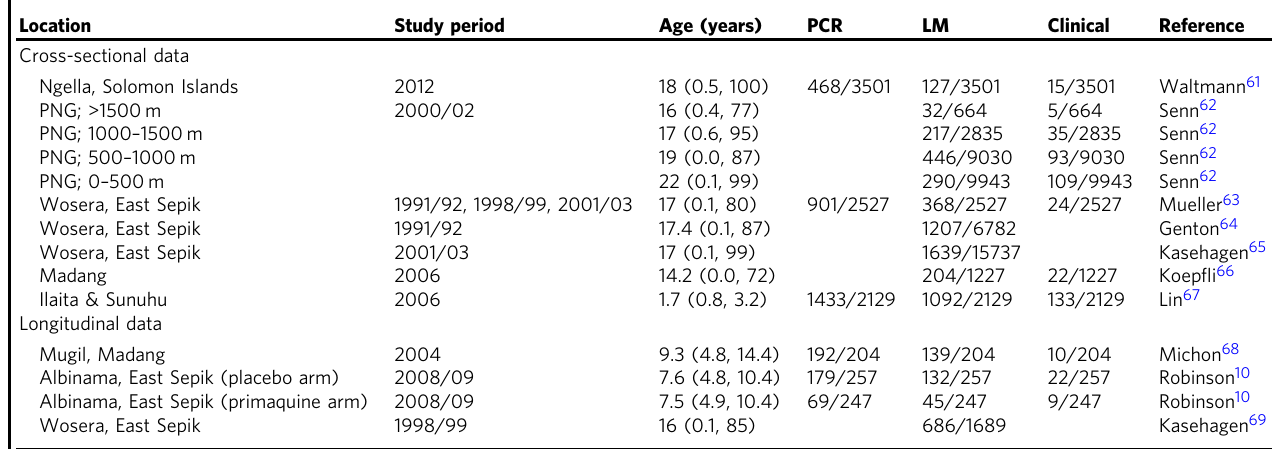
Table 1 Data from cross-sectional and longitudinal studies used for model calibration Location